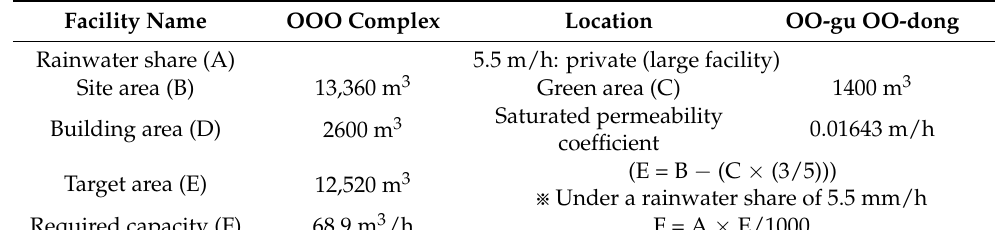
Table 11. Overview of the target site.